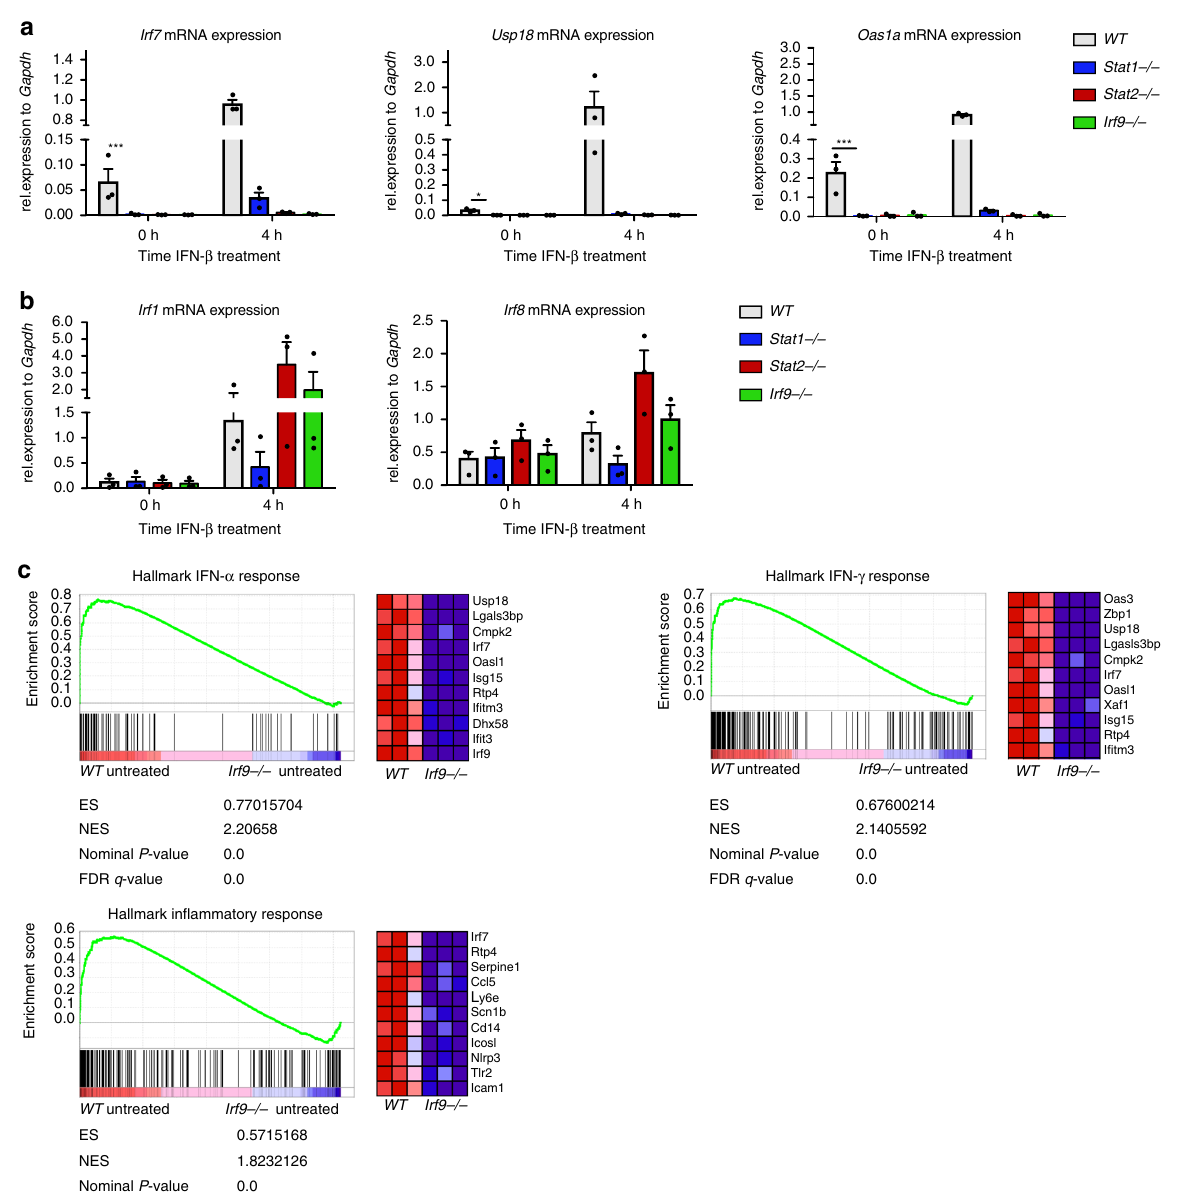
Fig. 1 Conditions of basal ISG expression. a , b Bone marrow-derived macrophages (BMDM) isolated from wild-type (WT), Stat1 − / − , Stat2 − / − , and Irf9 − / − mice were treated with 250 IU/ml of IFN- β as indicated. Gapdh-normalized gene expression was measured by RT-q-PCR. Data represent the mean and standard error of the mean (SEM) values of three independent experiments. P -values were calculated using the paired ratio t -test (* P ≤ 0.05; ** P ≤ 0.01; *** P ≤ 0.001). c Gene set enrichment analyses showing upregulation of an IFN and in fl ammatory response signature of untreated WT compared with untreated Irf9 − / − BMDM. The top correlated genes for each biological triplicate are displayed in the corresponding heat maps. The total height of the curve indicates the extent of enrichment (ES), with the normalized enrichment score (NES), the false discovery rate (FDR), and the P -value. Source data are provided as a source data fi and STAT2 – IRF9, respectively, after IFN- β treatment showed Fig. 3a – d; Supplementary Data 2 and 3). Binding of STAT2 and very similar binding preferences of both complexes with a IRF9 to ISG promoters was readily detectable in resting cells somewhat larger preference of STAT2 – IRF9 for ISREs containing (Fig. 3e). Similar to BMDM, STAT1 binding was observed at a a T nucleotide in position 14 (Supplementary Fig. 3c). majority of ISGs only after treatment with IFN- β . To extend our Taken together, the data are consistent with the notion that the analysis to human cells, THP-1 monocytes were rendered IRF9 switch from resting- to activated-state transcription is caused by a de fi cient using CRISPR – Cas9 technology (Supplementary Fig. 4a, transition from STAT2 – IRF9 to ISGF3 at a majority of ISG b). Similar to murine cells, the expression of many constitutive promoters. This fi nding was corroborated in mouse embryonic and IFN- β -induced genes was reduced by the Irf9 knockout fi broblasts, where basal ISG expression was reduced by IRF9 (Supplementary Fig. 4c, d, Supplementary Data 4 and 5). The de fi ciency in a gene set overlapping with IRF9-dependent genes gene set showed some overlap with IRF9-dependent genes in in BMDM, both resting and type I-IFN treated (blue symbols in BMDM, but many genes differed. We were not able to